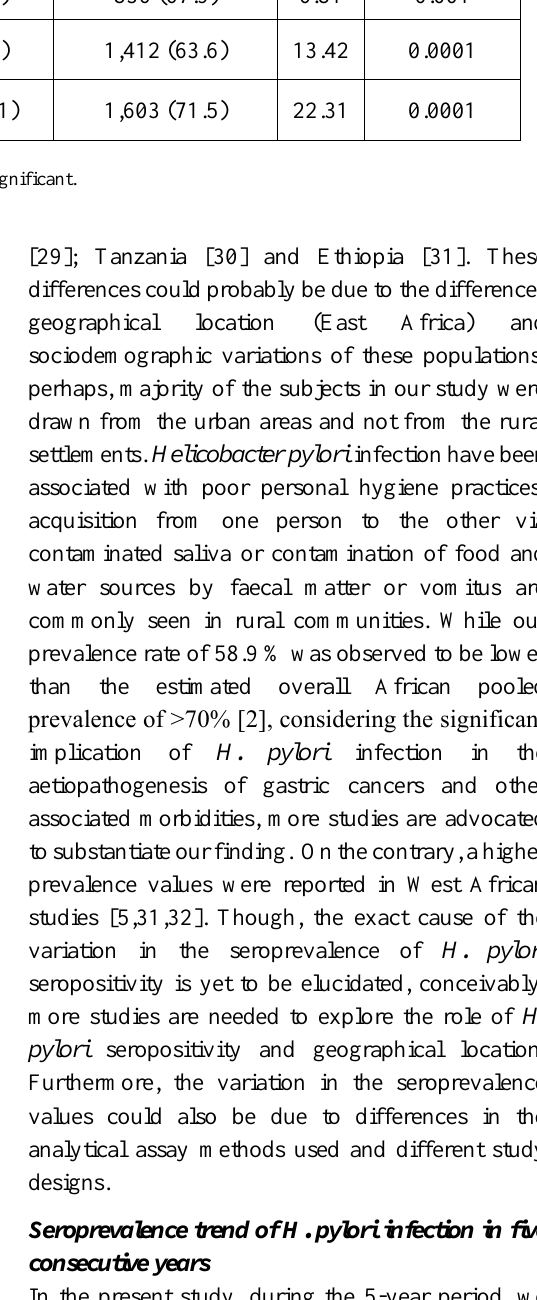
Where p -value of less than or equal to 0.05 is considered statistically